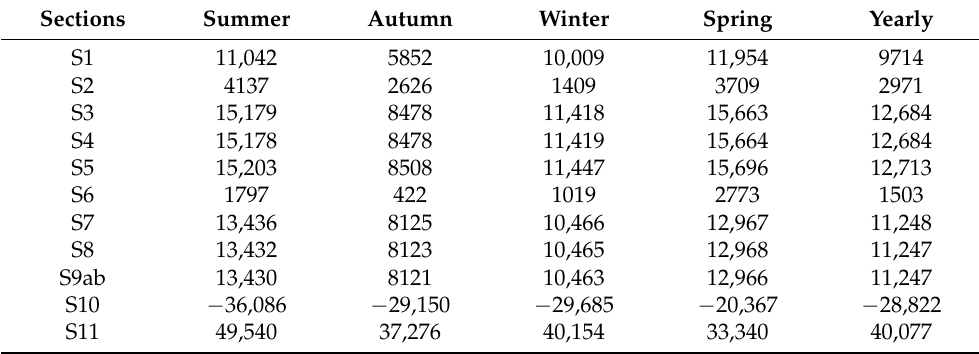
Table 3. Seasonal and yearly average fluxes through sections expressed in m 3 /s. Positive values indicate an eastward flow and negative values a westward one. The only exception is Section S6, with positive values for southward flows and negatives for northward